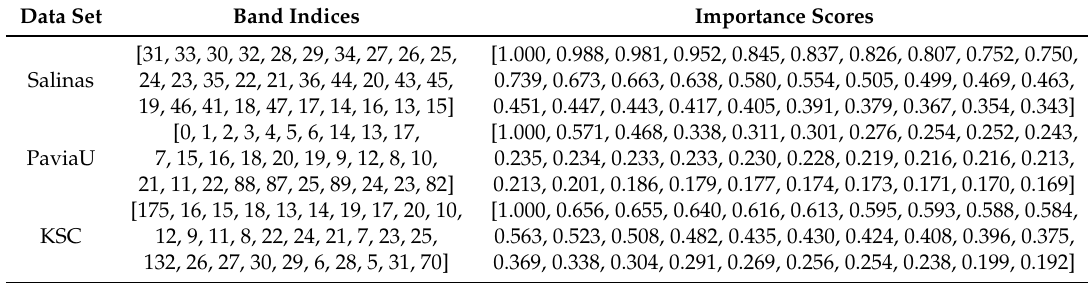
Figure 3. Flowchart of data processing, where Processing (1) is the processing performed by the data provider and Processing (2) is the processing performed in this paper. Table 3. Indices of the top 30 bands and their scores obtained by original Relief-F (ORF).